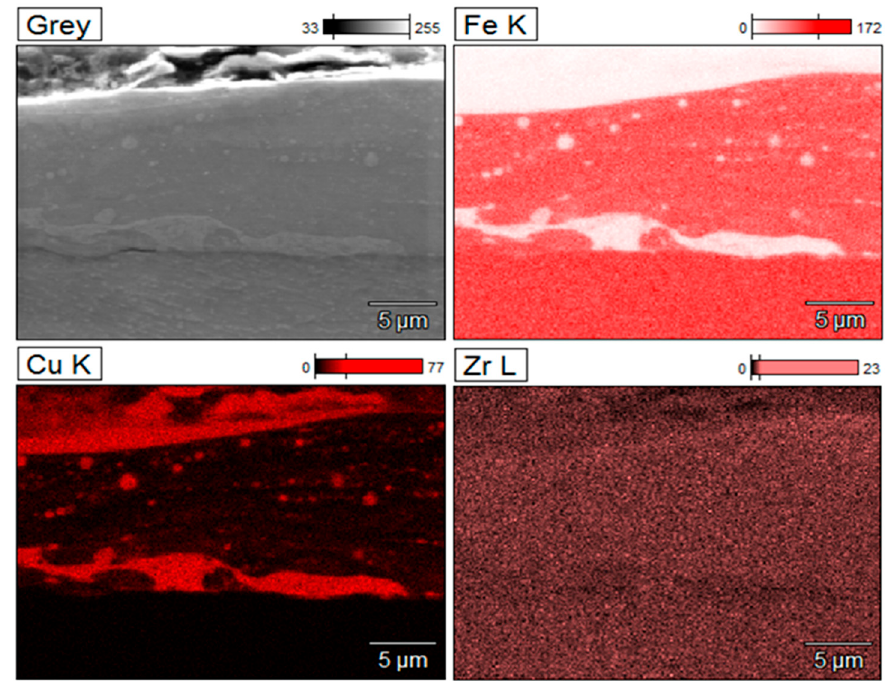
Figure 7. EDS mapping of the cross section of the machined surface for Ip = 9 A and Ton = 50 μ s.